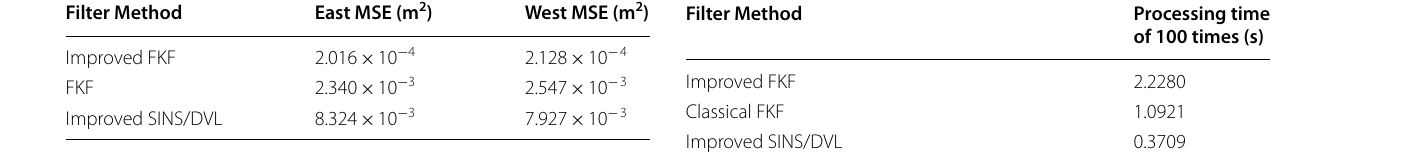
Table 2 The MSE comparison of different methods Filter Method